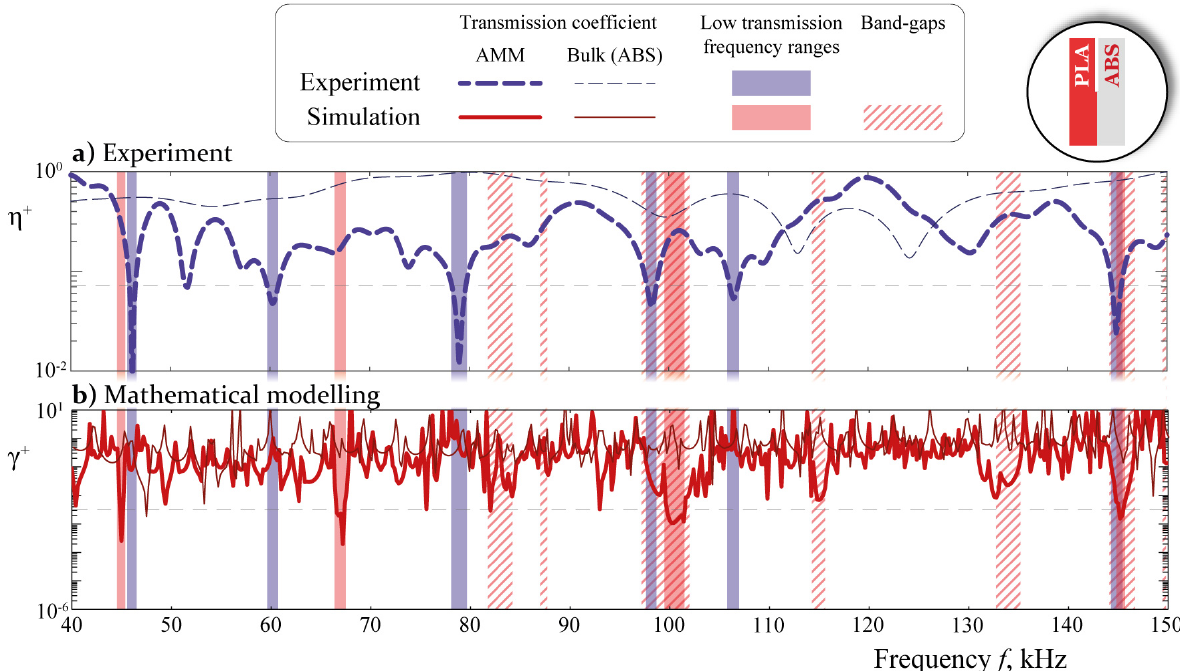
Figure 9. Experimental ( a ) and theoretical ( b ) and transmission coefficients η + ( f ) and γ + ( f ) , and the corresponding band-gaps for AMMs with edge voids.